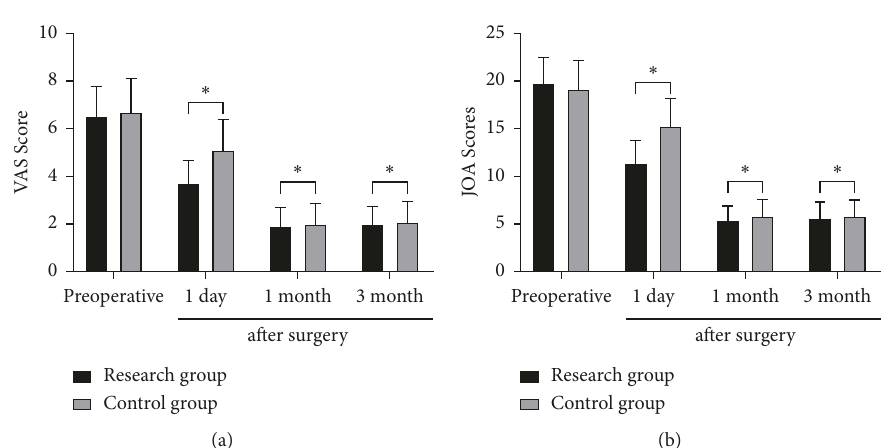
Figure 2: Comparison of the VAS score and JOA score between the two groups. (a) VAS Score. (b) JOA